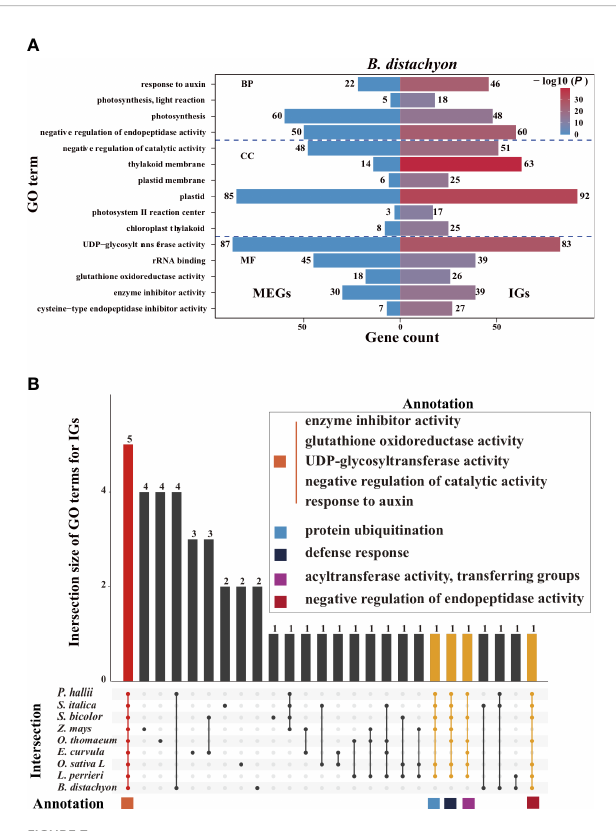
FIGURE 7 Enriched Gene Ontology (GO) terms. (A) Top 15 enriched GO terms among the B. distachyon (IGs, right) and MEGs (left). The color scale represents the P- values for the enrichment test. The number next to each bar represents the gene count for that GO term. (B) Intersection of the top 15 enriched GO terms for the IGs in nine Poaceae species. Bar colors represent the three subsets where all 9 (red), 6 – 8 (yellow), and 1 – 5 (black) species intersect. The common GO terms in at least six species are shown in the panel with colored